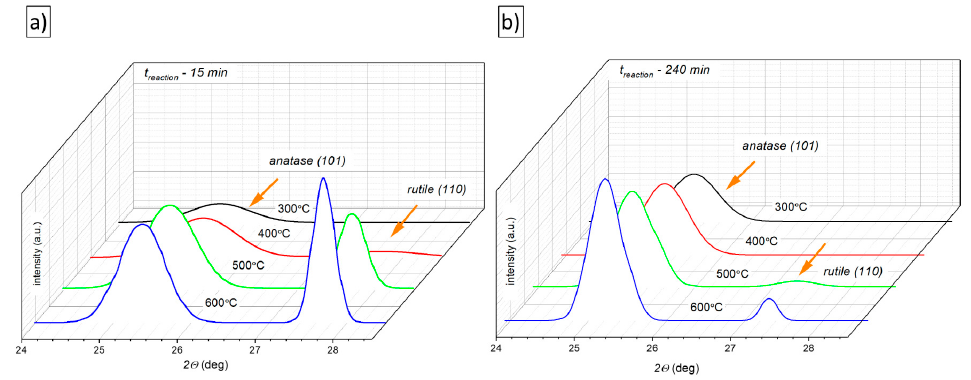
Figure 4. XRD in situ measurement (300°-600°C) of TiO 2 flower-like nanostructures obtained for 15 ( a ) and 240 min ( b ).